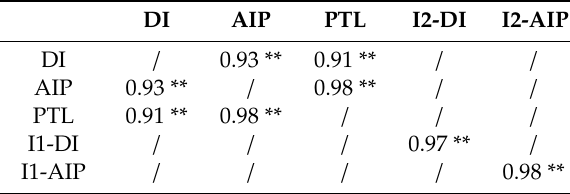
Table 2. Correlation Analysis of Important Data Sets based on the Pearson’s Coe ffi cient.